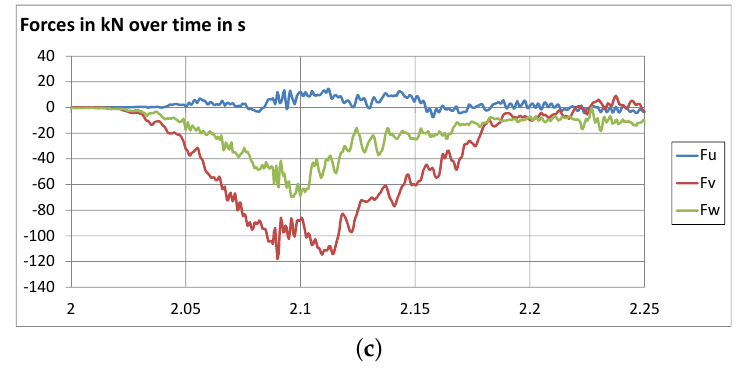
Figure 12. Test of a rockfall protection barrier system with clamped posts: ( a ) measurement; ( b , c ) resulting actions on foundation